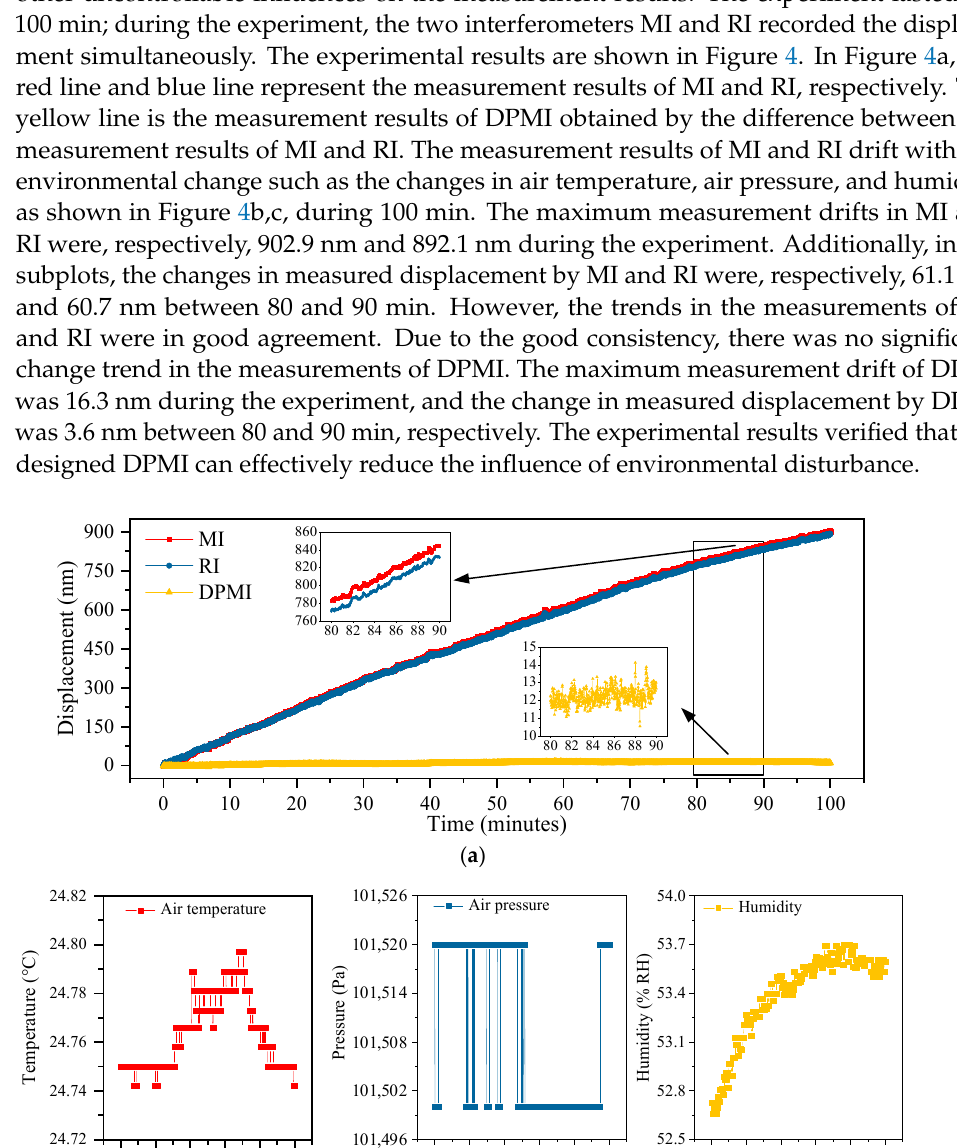
Figure 3. Constructed experimental setup.